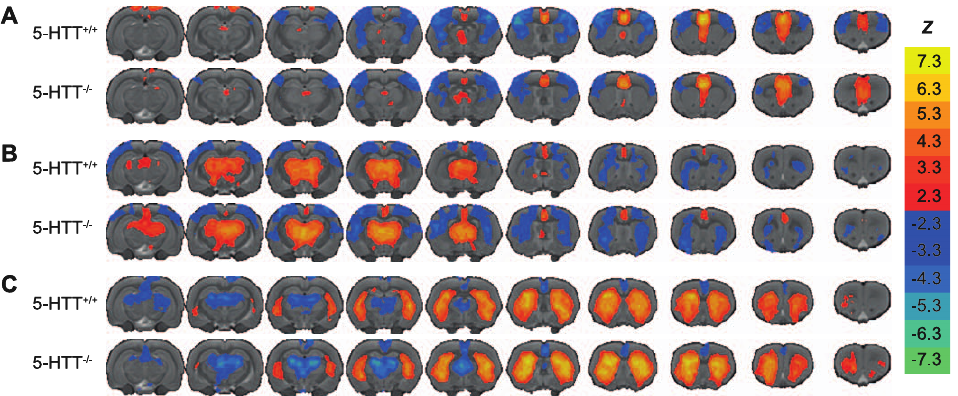
Figure 2. Maps of seed-based resting-state fMRI functional connectivities. The resting-state fMRI signal of a seed region was correlated with all voxels in the brain. For each voxel, a one-sample t -test was performed to determine whether the signal at that location correlated significantly with the seed-region. Group-level resting-state fMRI-based functional connectivity maps are displayed for three different seed regions. Voxels that exhibit significant ( p , 0.01, cluster-corrected) functional connectivity with a seed region in (A) ventromedial prefrontal cortex, (B) thalamic nuclei, and (C) caudate-putamen, are color-coded according to Z -value thresholded at 2.3 ( p , 0.01) for both positive (red to yellow) and negative (blue to light blue) correlations between the filtered time-varying signals, and overlaid on a multi-slice anatomical rat brain template.